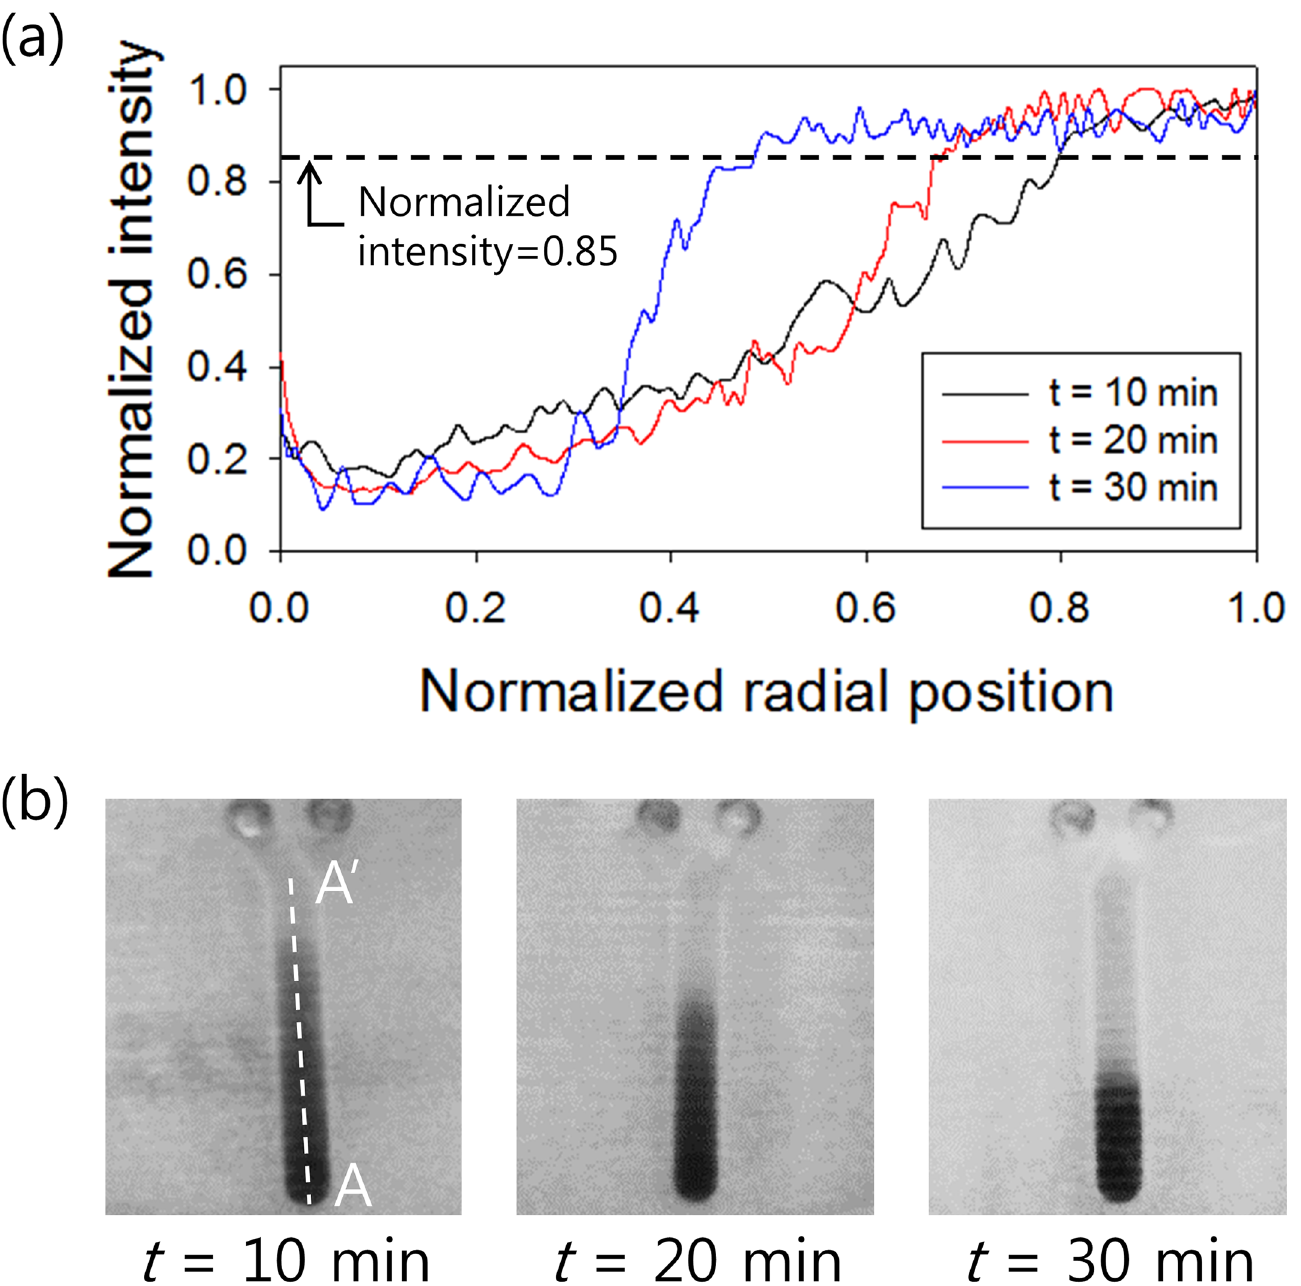
Fig 2. Analysis of CI using normalized intensity. (a) Normalized intensities in the fluidic channel of the 3D-PMD device as a function of normalized radial position at different time rotation durations (10, 20, and 30 min). The dotted line indicates the normalized intensity of 0.85. (b) Photographs of a single unit of the fluidic channel 10, 20, and 30 mins after beginning 3D-PMD rotation. White dotted line (A-A’) shows the radial position in the fluidic channel for intensity